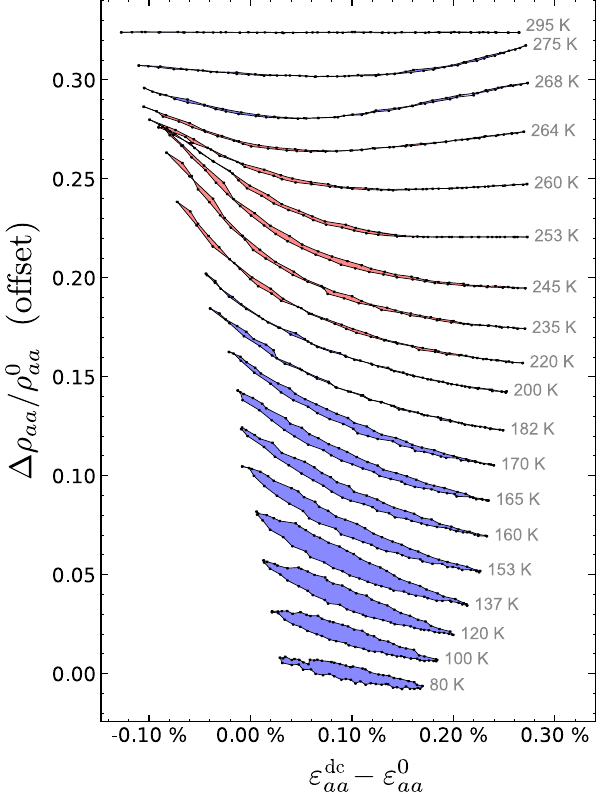
FIG. 11. Resistivity stress-cycle data for a second sample of ErTe 3 , showing a similar phenomenon, but with a decreased magnitude of the effect. We attribute this difference to differences in the accessible range of strains in our experimental